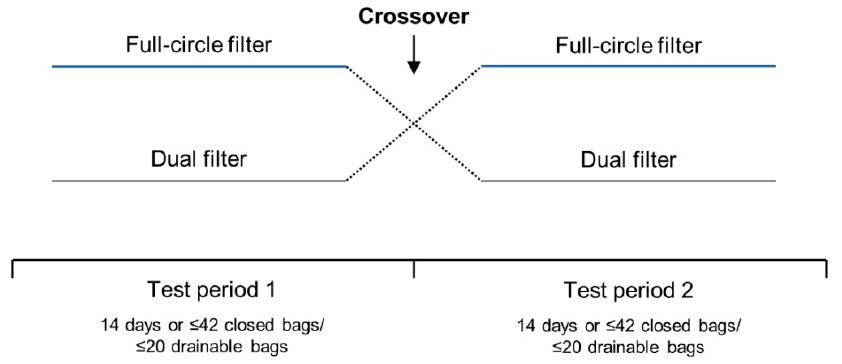
Figure 1. Two-way crossover study design used for the two trials.